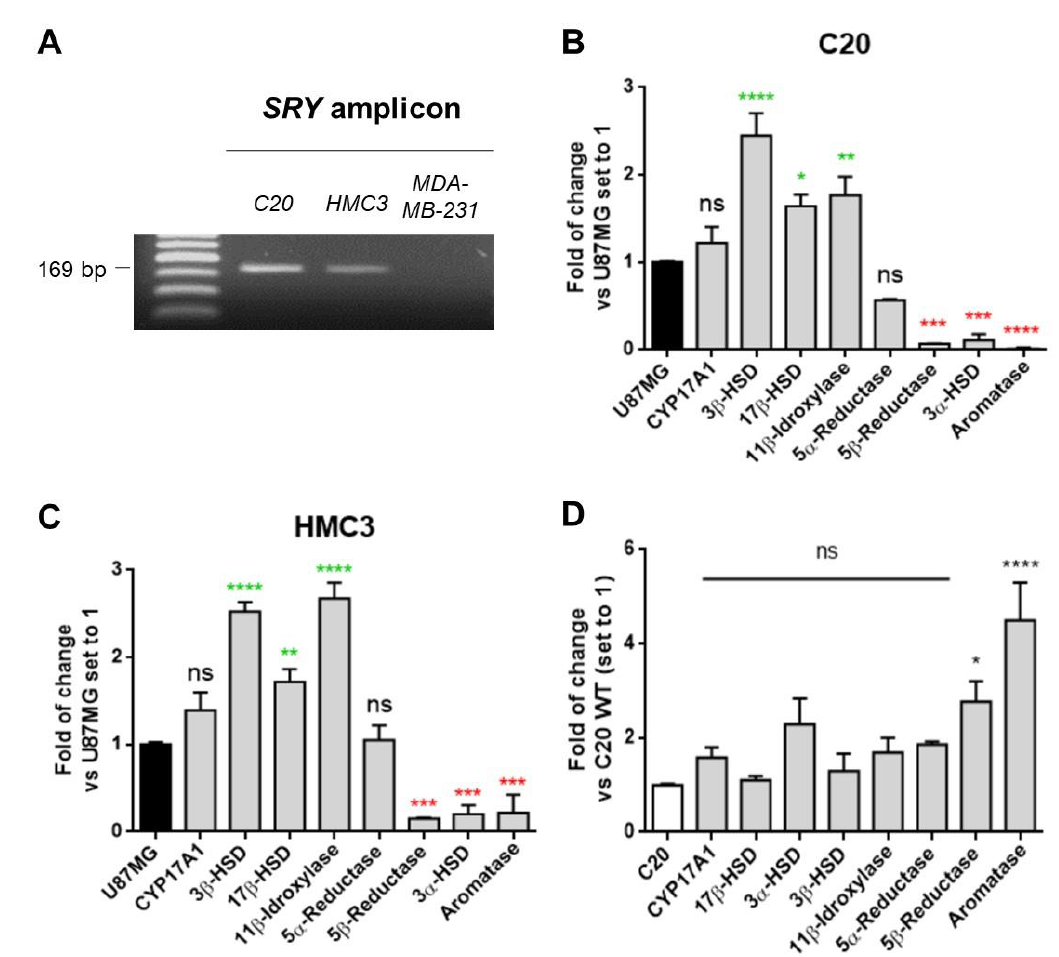
Figure 3. C20 and HMC3 cells: gendered origins and expression profiles of the enzymes involved in the neurosteroid biosynthetic pathway. ( A ) Results of genomic PCR evidenced the presence of SRY in both the microglial cells, suggesting their derivation from male individuals, whereas no amplicon was detected for the female-derived cell line MDA-MB.231. ( B ) and ( C ) The figures show the fold change analysis in mRNA levels of the enzymes involved in the neurosteroid biosynthetic pathway, comparing real-time RT-PCR data obtained from C20 and HMC3 cells to data of U87MG cells (set to 1). High mRNA levels for 17 β –HSD, 3 β –HSD, and 11 β -hydroxylase; and very low mRNA levels for 5 β -reductase, 3 α -HSD, and aromatase were observed in C20 and HMC3 cells. The bars represent the means ± SEMs of three different experiments, and the significance of the differences was determined by one-way ANOVA, which was followed by Bonferroni’s post-test: * p < 0.05, ** p < 0.01, *** p < 0.001, **** p < 0.0001 vs. U87MG. ( D ) The mRNA data of the investigated enzymes were also compared between the two human microglial cell types, while setting C20 expression values to 1. No significant differences were evaluated for most of the enzymes, except for 5 β -reductase and aromatase, which resulted in higher expression in HMC3 with respect to C20 cells. The significance of the differences was determined by one-way ANOVA, which was followed by Bonferroni’s post -test: * p < 0.05, **** p < 0.0001 vs. C20.